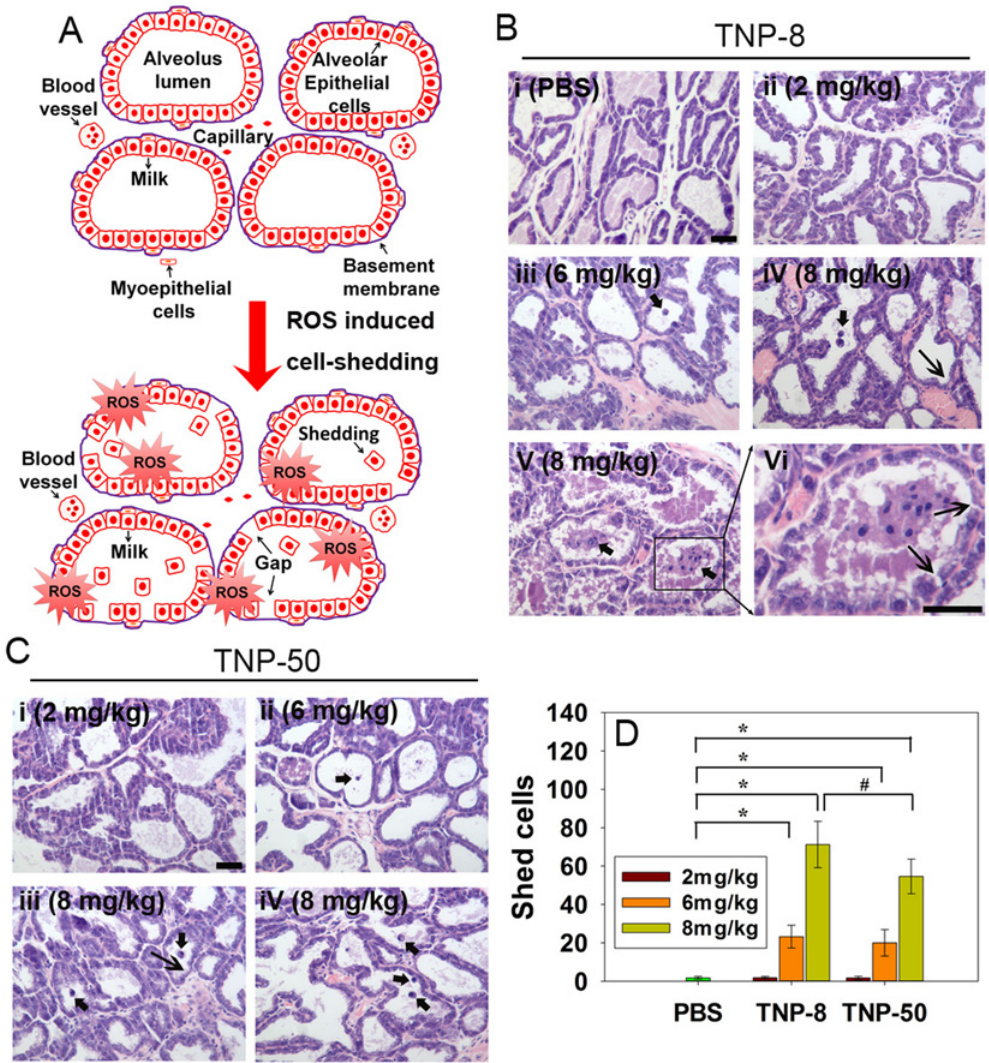
Fig 4. Shedding of mammary alveolar epithelial cells induced by TNPs. A. Schematic anatomical diagrams of lactating mammary glands during lactation period and cartoon indicates that ROS induced cell shedding. B. Representative histological micrographs of the mammary glands 10 days after treatment with (i) PBS; (ii) TNP - 8 at a dose of 2 mg/kg; (iii) TNP - 8 at a dose of 6 mg/kg; (iv) TNP - 8 at a dose of 8 mg/kg. Cell shedding and barrier loosening are noted; (v) Severe cell shedding into alveolar lumen is evident at a dose of 8 mg/kg; (vi) An enlarged view of cell shedding. C. Representative histological micrographs of the mammary glands 10 days after treatment with (i) TNP - 50 at a dose of 2 mg/kg; (ii) TNP - 50 at a dose of 6 mg/kg; (iii) TNP - 50 at a dose of 8 mg/kg; (iv) Cell shedding into alveolar lumen is observed at a dose of 8 mg/kg. D. Quantification of numbers of mammary alveolar epithelial cells shed into the alveolar lumen. There were 7 mice in each experimental group and around 100 alveoli images were examined for each mouse. Scale bar: 40 μ m; Narrow arrows indicate gap; Thick arrows indicate cell shedding.